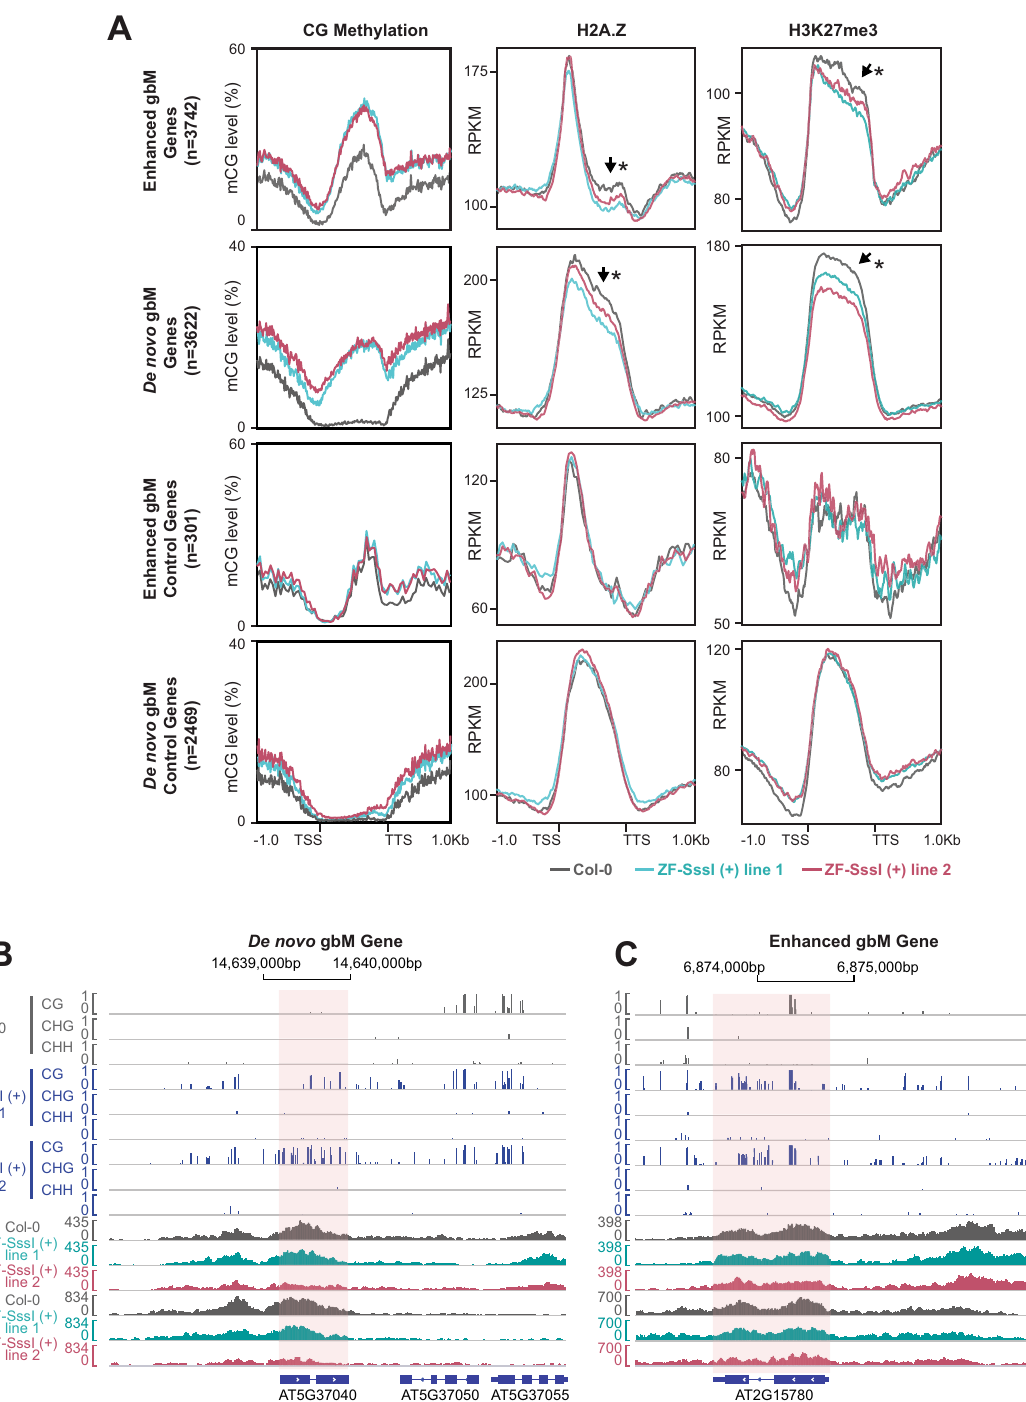
Fig. 5 H2A.Z and H3K27me3 reduction over hypermethylated genes. A Metaplots of CG methylation (T2 and T3 merged), H2A.Z, and H3K27me3 levels in Col-0 and two representative ZF-SssI ( + ) lines over genes with ‘ Enhanced gbM ’ or ‘ De novo gbM ’ as well as a set of control genes with similar gene body CG methylation but no hypermethylation. * p- value < 0.05, Welch Two-Sample t -test ( ‘ De novo gbM ’ group, hypothesis testing performed on full- length genic regions; ‘ Enhanced gbM ’ group, hypothesis testing performed on last 50% of genic regions). The black arrow indicates the regions with reduced H2A.Z and H3K27me3. B, C Screenshot of WGBS tracks in Col-0 and two representative T2 ZF-SssI ( + ) lines, as well as H2A.Z and H3K27me3 ChIP-seq tracks in Col-0 and two representative T2 ZF-SssI ( + ) lines over selected ‘ De novo gbM ’ ( B ) and ‘ Enhanced gbM ’ ( C ) genes. Source data underlying Figure 5A are provided as a Source Data fi